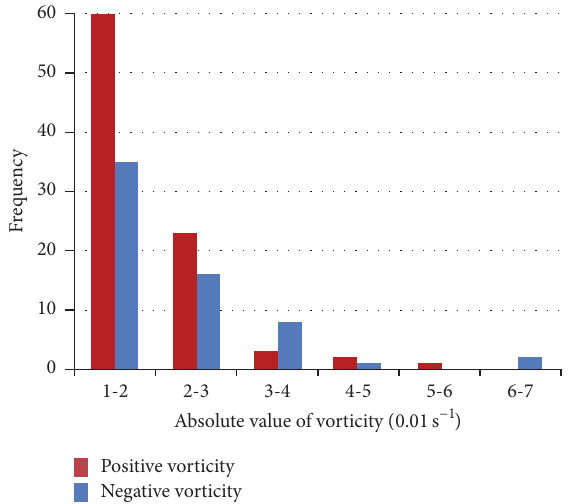
Figure 13: The frequency distribution of the absolute values of negative and positive vorticity in baby-rain-cells.